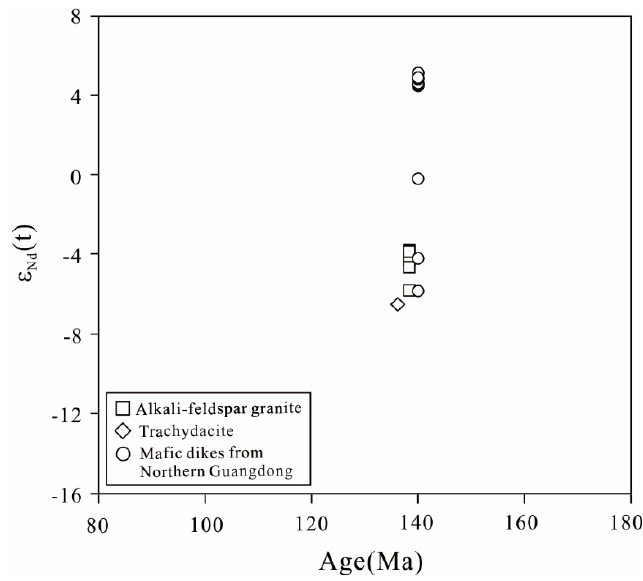
Figure 7. Age vs. ε Nd (T) diagrams for the Tiantangshan alkali-feldspar granite and trachydacite. Also shown are the fields of the Early Cretaceous gabbros in northern Guangdong [33].